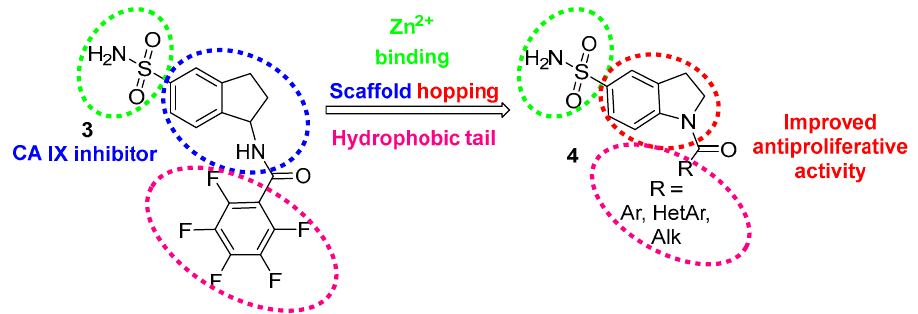
Figure 2. Scaffold hopping approach for the design of novel CA inhibitors based on indoline-5- sulfonamide core 4 .